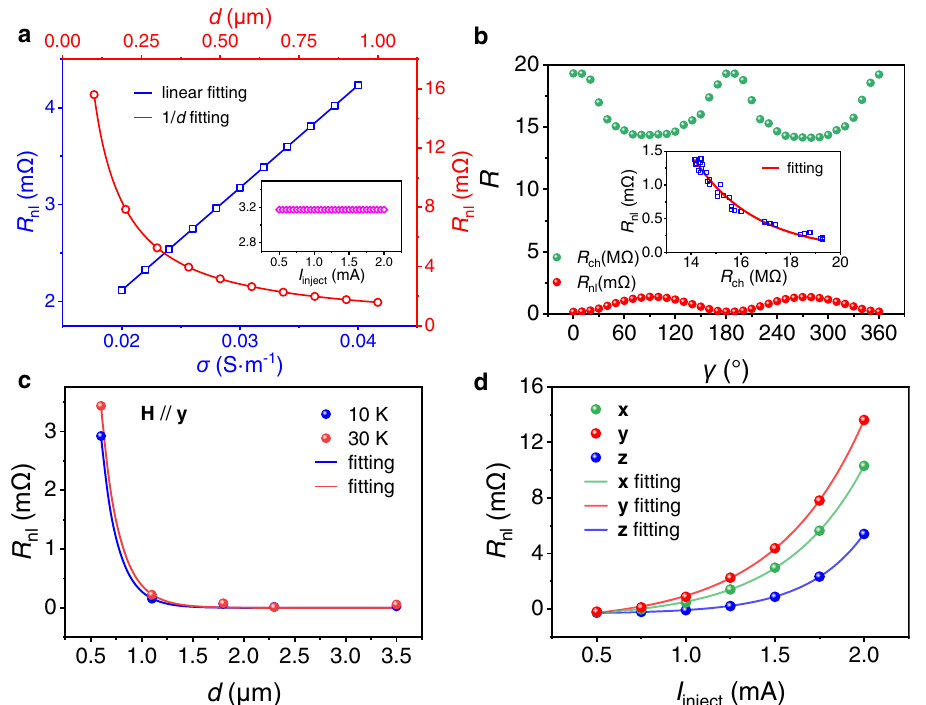
Fig. 4 | Diffusive transport mechanism in nonlocal measurements. a Simulated dependenceof nonlocalresistance ( R nl )ontheconductivityofthechannel σ (blue, bottom and left axes), the distance between two electrons d (red, top and right axes) and I inject in the inset using the fi nite element analysis. The geometry of the device is the same as the experiments and the material of the channel is set to